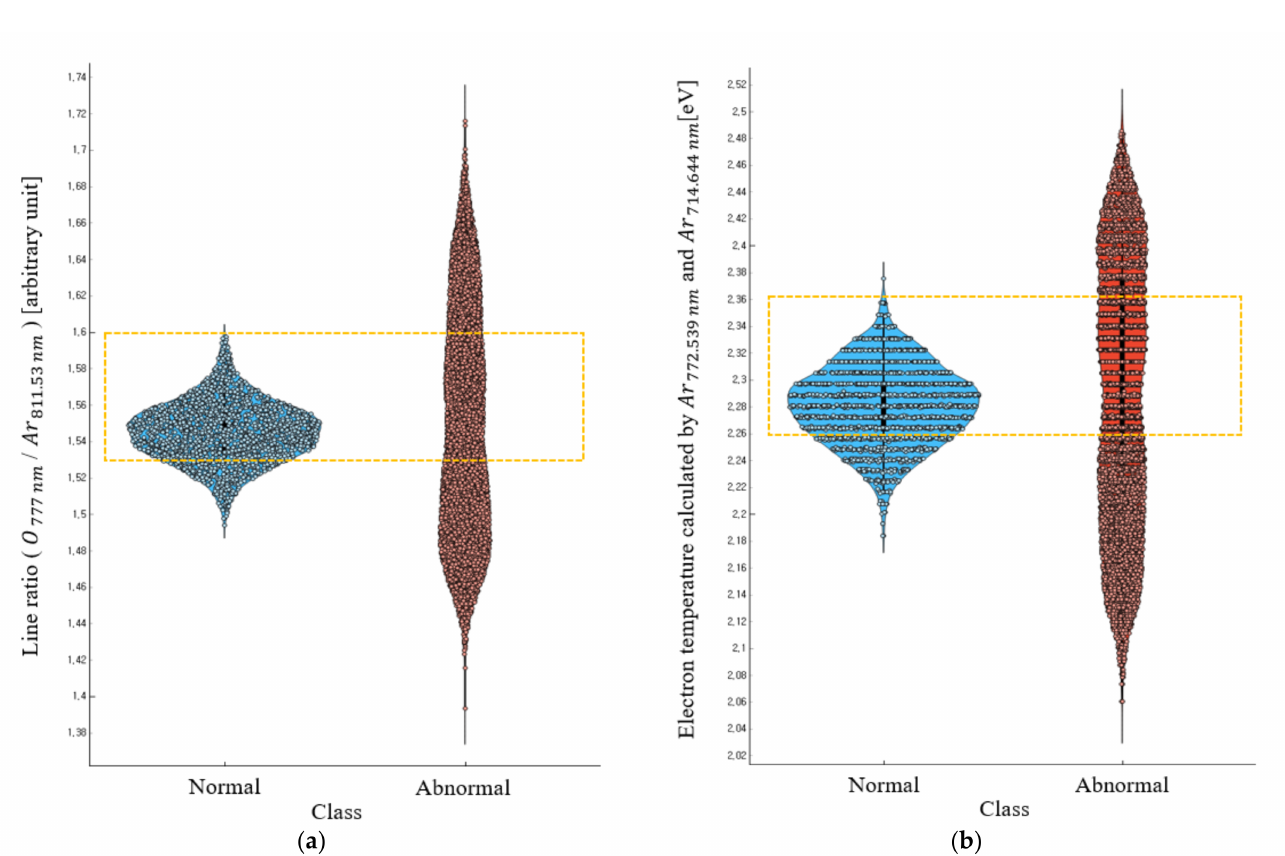
Figure 8. Data distributions of the ( a ) line ratios and ( b ) electron temperatures using violin